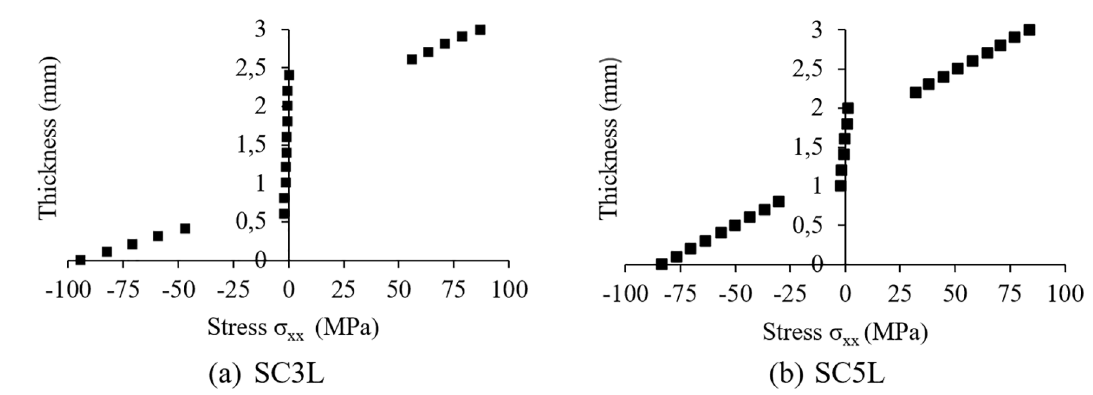
Figure 7. Stress x Thickness for (a)SC3L; (b)